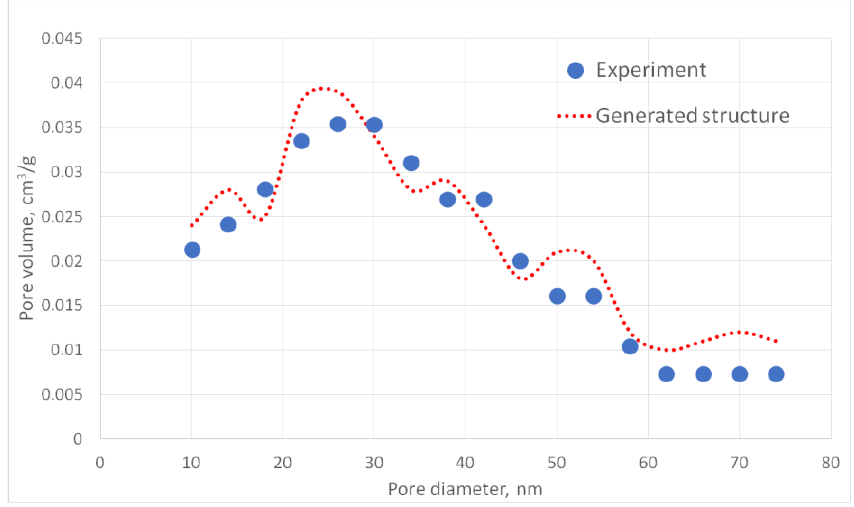
Figure 10. Pore size distribution curves for the experimental sample of carbon aerogel PA-C and the corresponding generated structure.